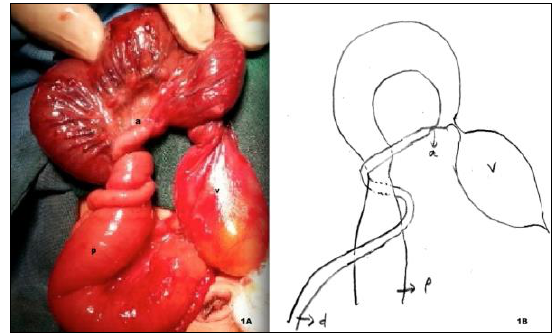
Figure 1A: Segmental volvulus of ileum around the axis of mucous filled vitellointestinal duct remnant (v). Site of atresia (a) is close to attachment of ileum and remnant. Proximal dilated (p) and distal col- lapsed (d) ileal segments are shown. 1B – Line diagram showing the same findings. a-type II